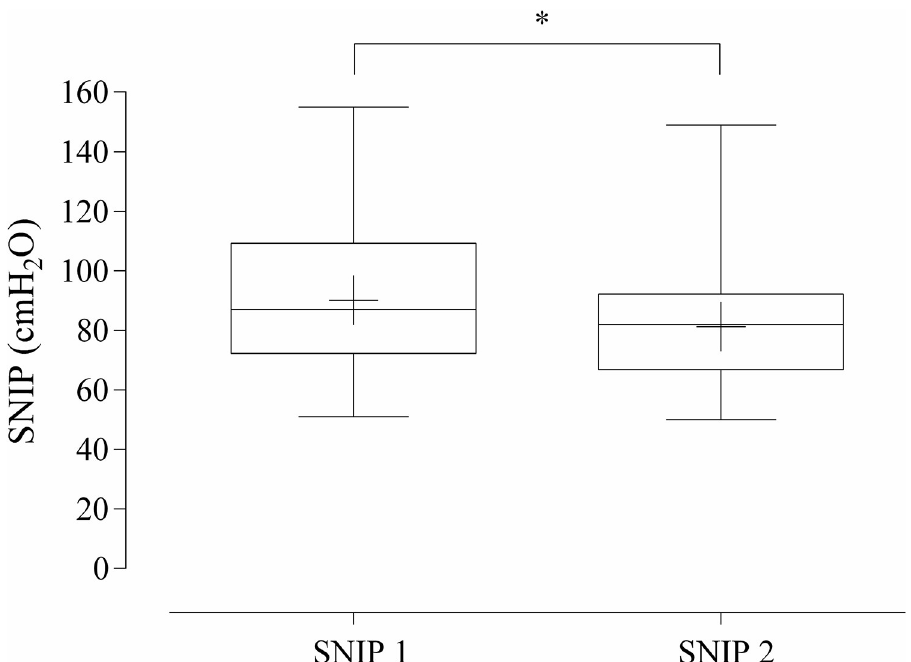
Fig 3. SNIP maneuver (cmH 2 O). Box and Whiskers representing the comparison between the highest SNIP between the 11 th and 12 th maneuvers (SNIP 1) and the highest SNIP reached before the 10 th maneuver (SNIP 2). + = SNIP mean; � p <